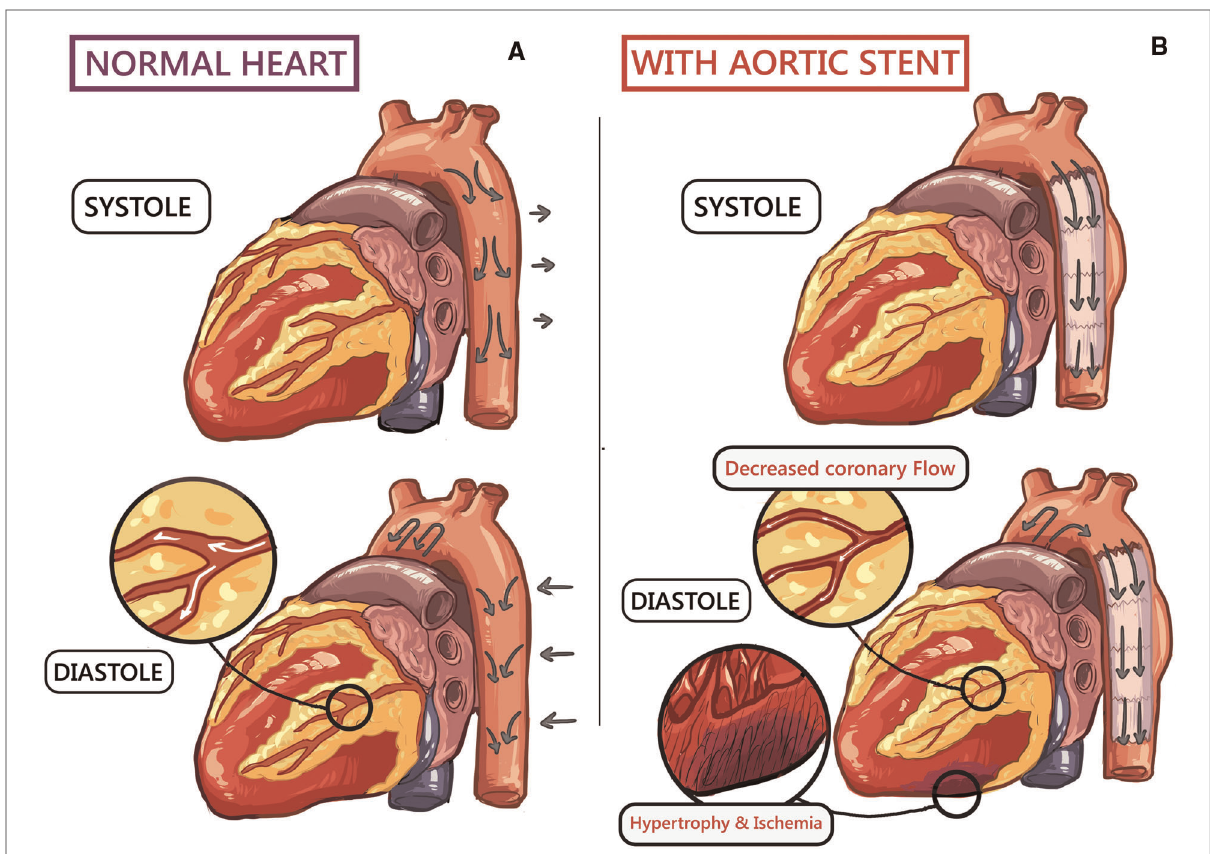
FIGURE 1 A schematic human heart diagram showing (10): ( A ) normal cardiovascular hemodynamics during systole and diastole. ( B ) Endograft in the thoracic aorta increases arterial stiffness, causing left ventricular (LV) strain and subsequent hypertrophy. Furthermore, impaired LV fi lling decreases coronary blood fl ow, resulting in non-occlusive